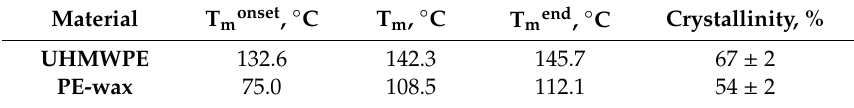
Table 2. DSC test results for the UHMWPE and PE-wax powders ( ± the standard deviation).